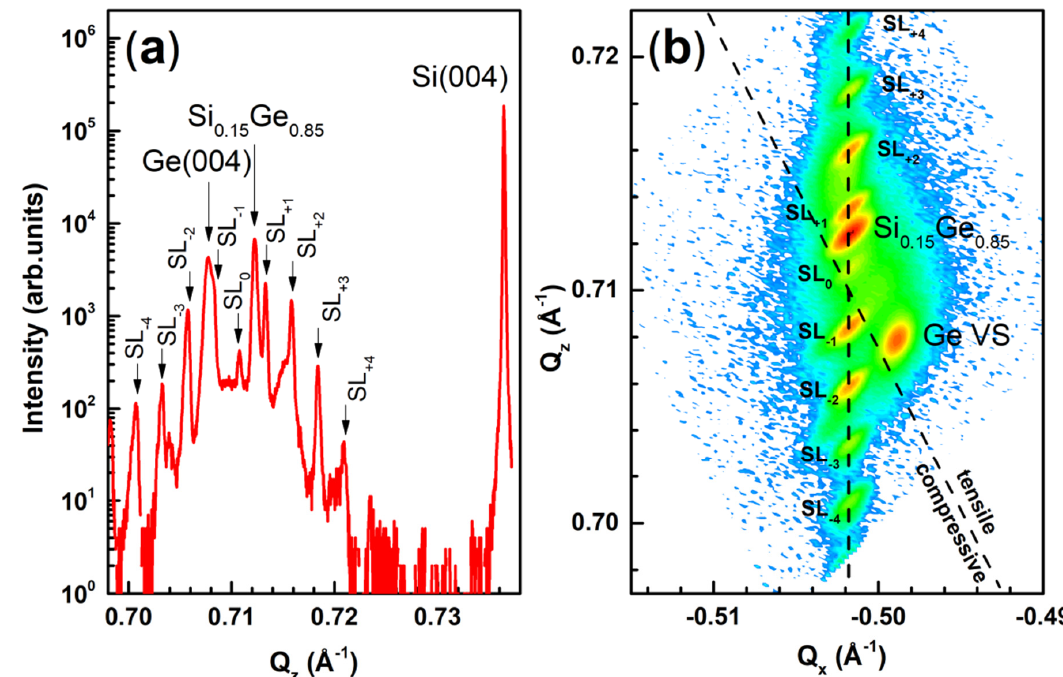
Figure 2. ( a ) XRD rocking curve around the (004) reflection and ( b ) XRD reciprocal space map (RSM) around the (224) reflections of the SiGe sample 2223. We labelled the peaks associated to the Si substrate, the Ge buffer and the thick Si 0.15 Ge 0.85 alloy buffer of the VS, as well as different orders of the superlattice (SL) fringes.